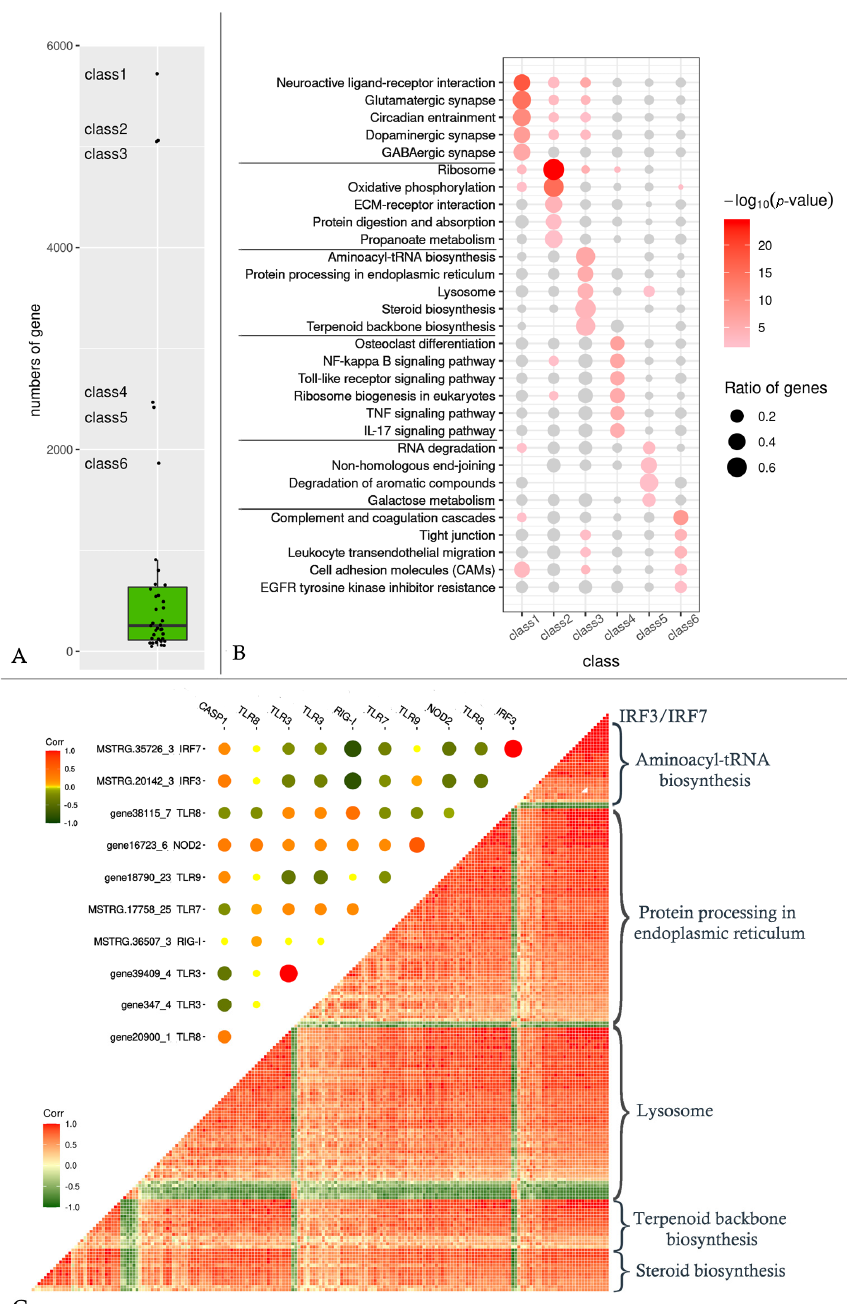
Figure 5. The curation of WGCNA analysis. ( A ) The scatter boxplot of gene counts for 39 classes. ( B ) The KEGG enrichment of the 6 outlier classes. The y-axis shows the top 5 enriched pathways of each class and the bubbles show the enrichment of the 6 classes on these selected pathways. ( C ) Upper triangle shows the correlation coefficients between IRF3/IRF7 and PRRs. The naming rule for the y-axis is GeneID_class NO. Symbol, and the tag of the x-axis is simplified to symbol. Lower triangle shows the correlation coefficients between IRF3/IRF7 and the genes in the top 5 enriched pathways of class